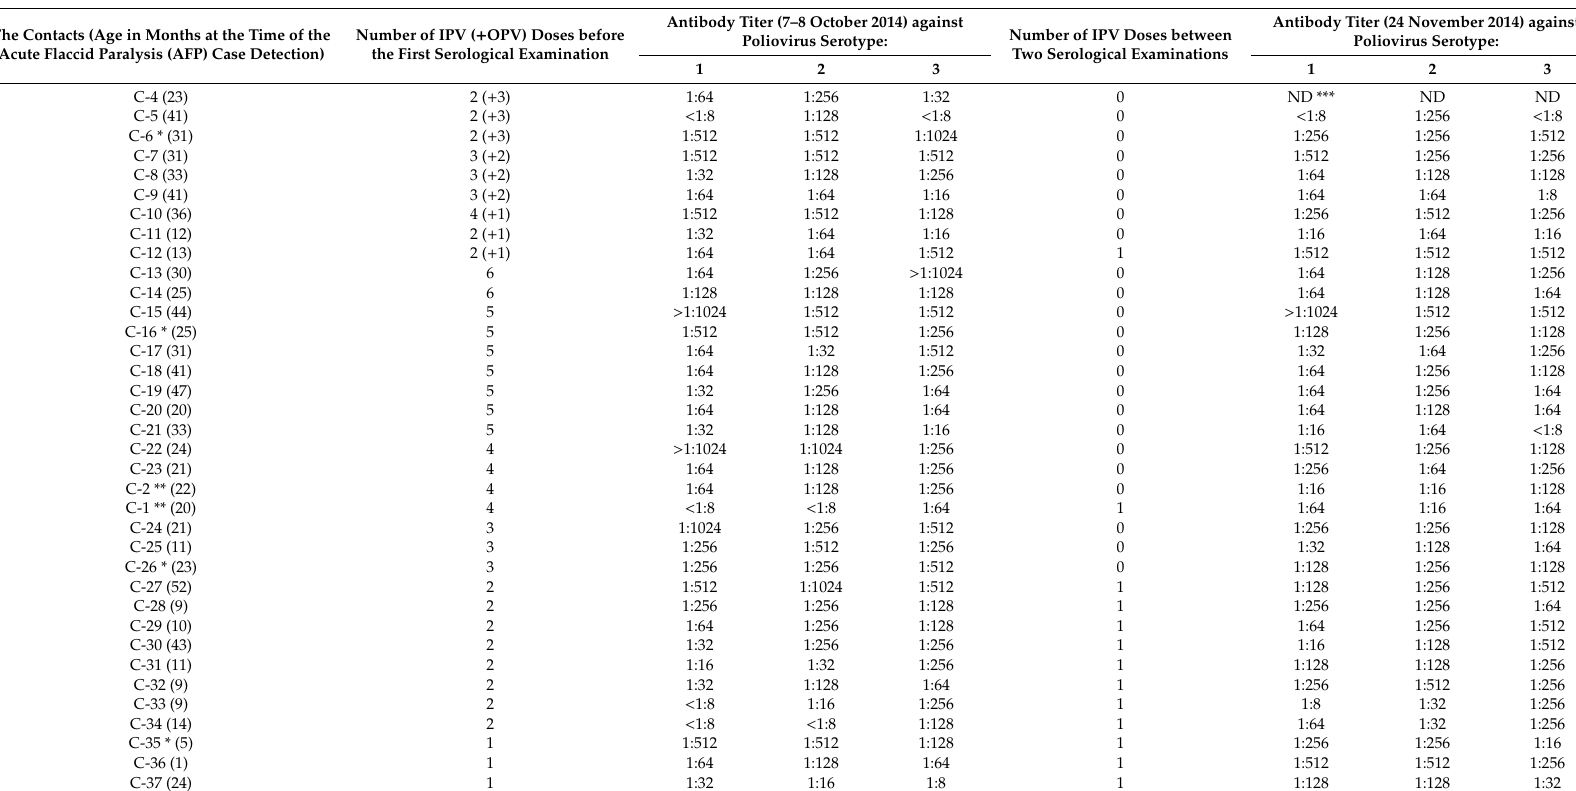
Table 1. Number of doses of inactivated poliovirus vaccine (IPV) and oral poliovirus vaccine (OPV) and level of neutralizing antibodies against polioviruses types 1, 2 and 3 in the sera of the contacts (arranged in accordance of the poliovaccine doses acquired). Antibody Titer (7–8 October 2014) against The Contacts (Age in Months at the Time of the Number of IPV ( + OPV) Doses before Poliovirus Serotype: Number of IPV Doses between Two Serological Acute Flaccid Paralysis (AFP) Case Detection) the First Serological Examination